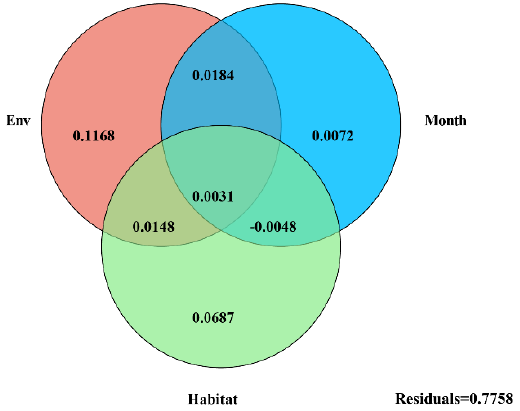
Microorganisms 2021 , 9 , x FOR PEER REVIEW Figure 4. Variation partitioning analysis performed to quantify the contribution of environmental variables, sampling month and habitat to bacterial community variations.